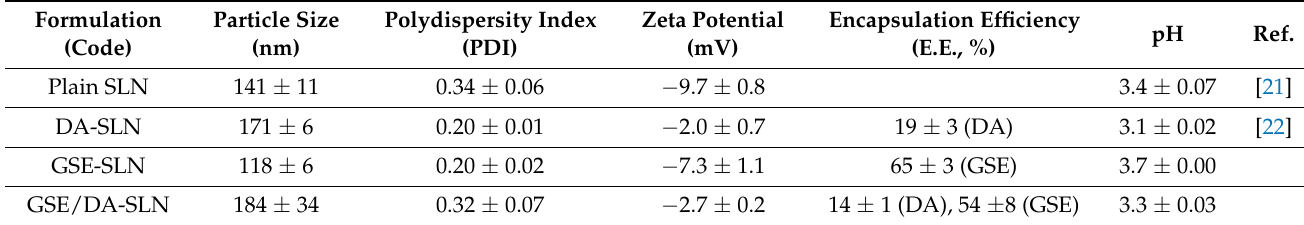
Table 1. Physico-chemical Characterization of